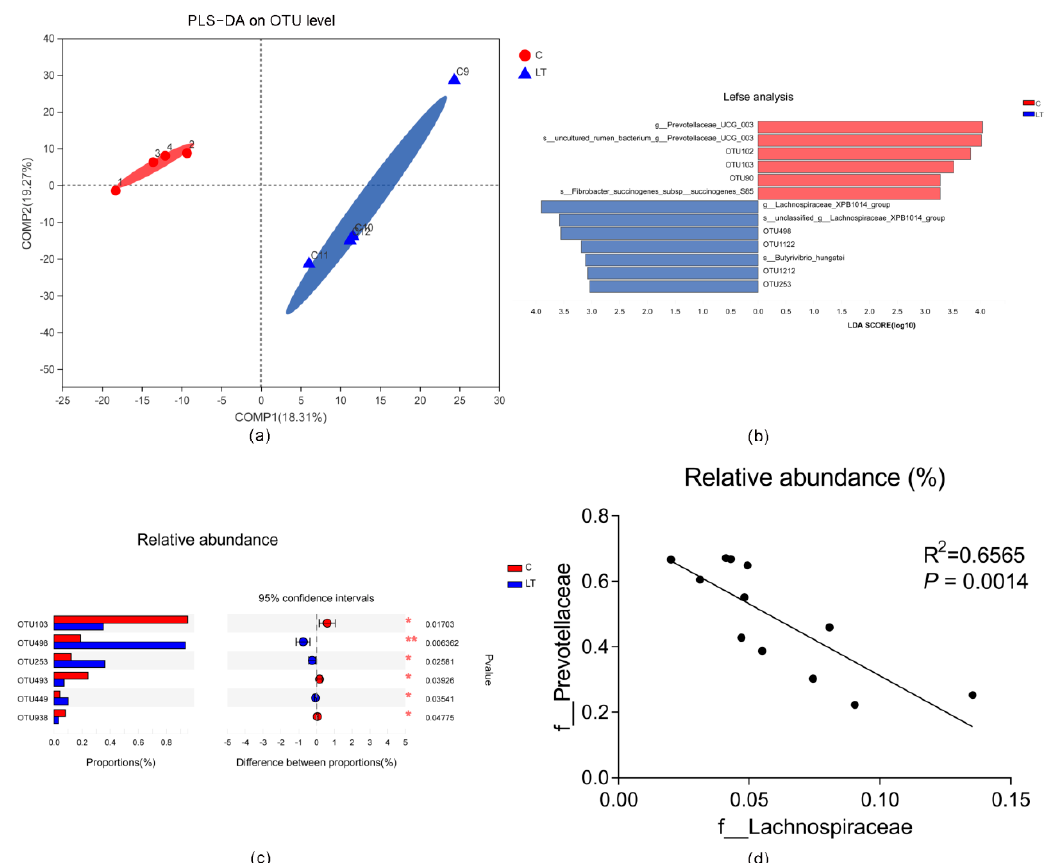
Figure 2. Effects of cold temperature on the microbiota of the rumen. ( a ) Partial least squares discrimination analysis (PLS-DA) of microbial diversity in the C and LT groups. ( b ) Lefse analysis of microbial diversity in the C and LT groups. ( c ) Bacterial composition at the OTU (operational taxonomic units) level. ( d ) The relationship between Lachnospiraceae and Prevotellaceae based on a Spearmen analysis. C, sheep exposed to 5 °C, and LT, sheep exposed to − 15 °C. *, p < 0.05; **, p < 0.01.